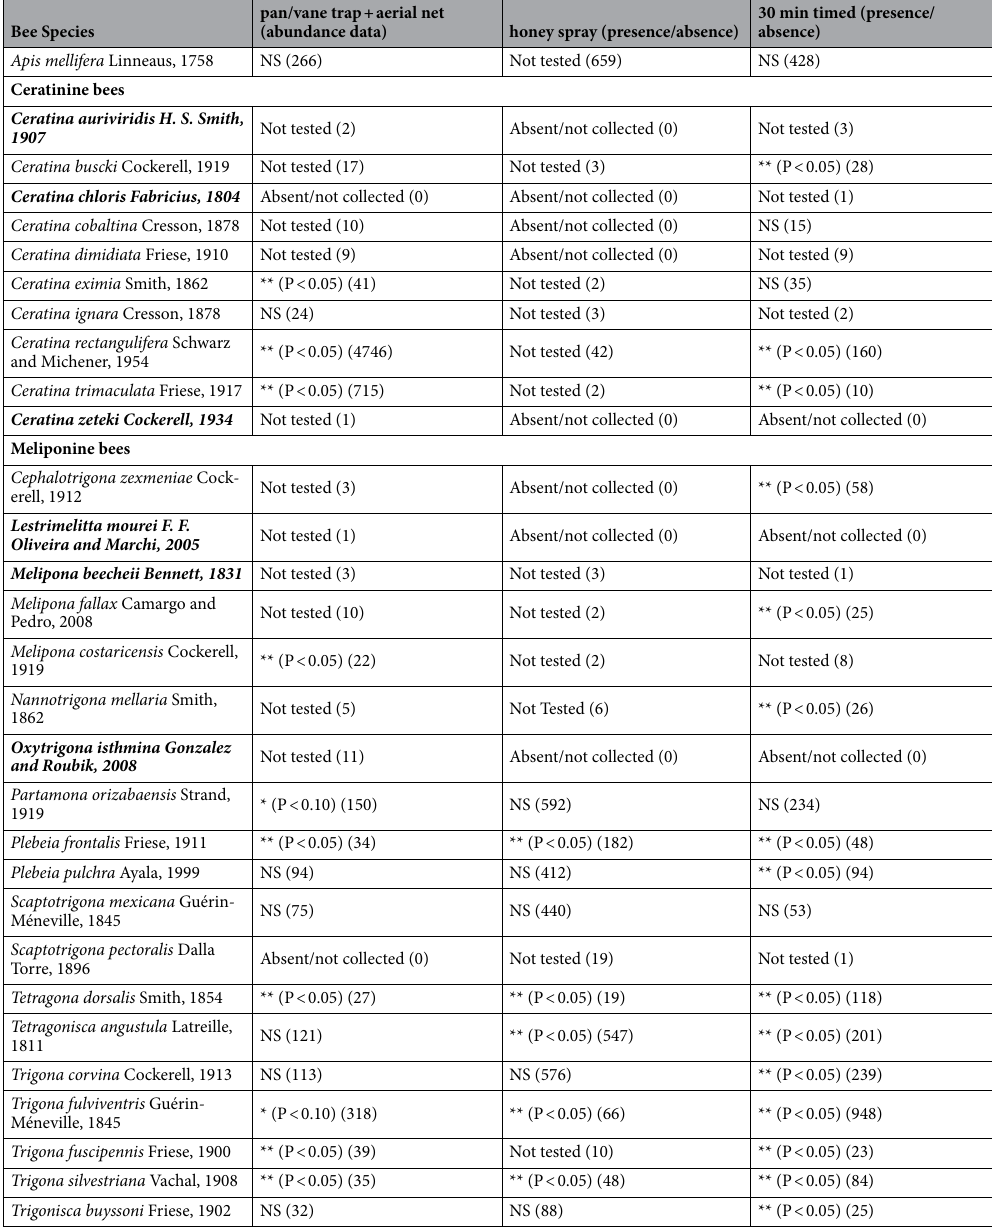
Table 1. GLMM and LMM results of the effect of elevation on each bee species’ abundance and presence in the various collection methods. Bolded Italics species are the six species that could not be statistically tested from any collection method, with ≦ 11 individuals collected from all methods combined. NS is abbreviation for Not Statistically Significant. The abundance for each species is shown in parenthesis following the result of the statistical